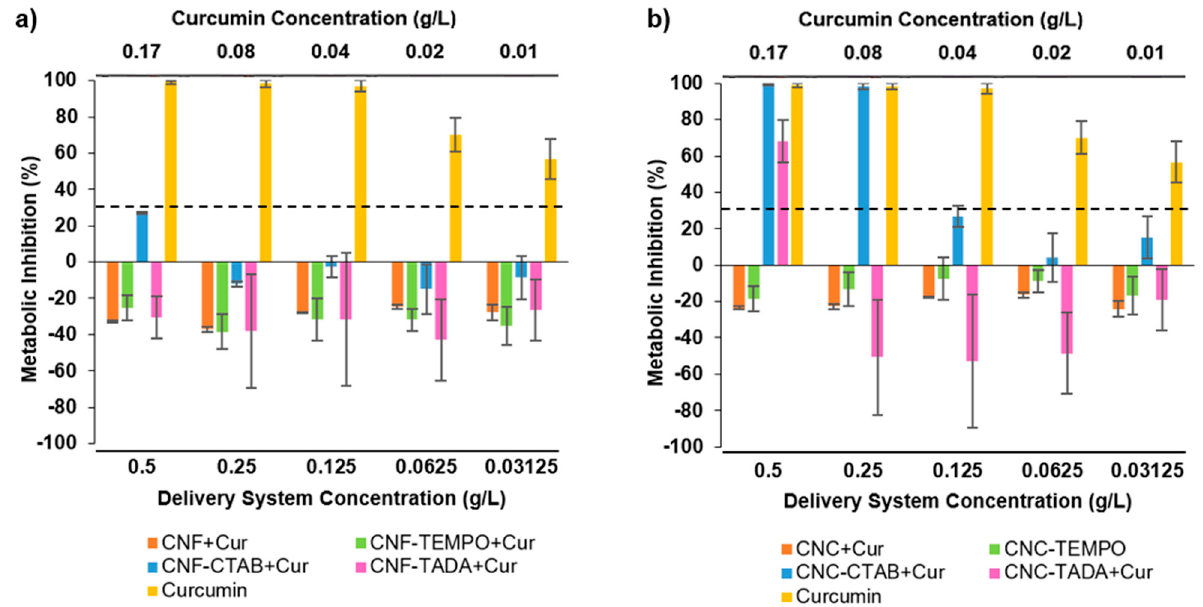
Figure 7. Impact of pure curcumin and modified and unmodified cellulose nanofiber (CNF) ( a ) and cellulose nanocrystal (CNC) ( b ) systems encapsulating curcumin upon Caco-2 cells metabolic activity. Nanocellulose modifications have been performed with cetyltrimethylammonium bromide (CTAB), tannic acid and decylamine (TADA), and by TEMPO-mediated oxidation (TEMPO). The dotted line represents the 30% cytotoxicity limit as defined by the ISO 10993-5:2.